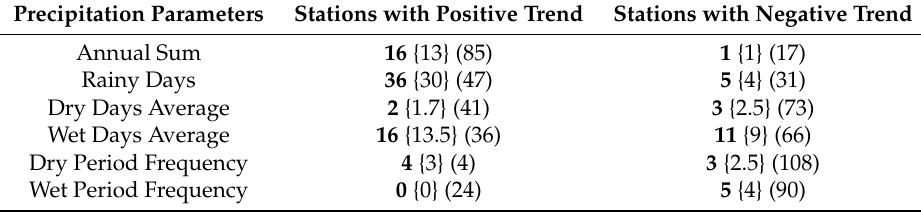
Table 2. Trend statistics for the precipitation parameters during the cropping season. Format of the results: stations with a significant trend {stations with significant trend as a percentage of the total number of stations} (stations with an insignificant